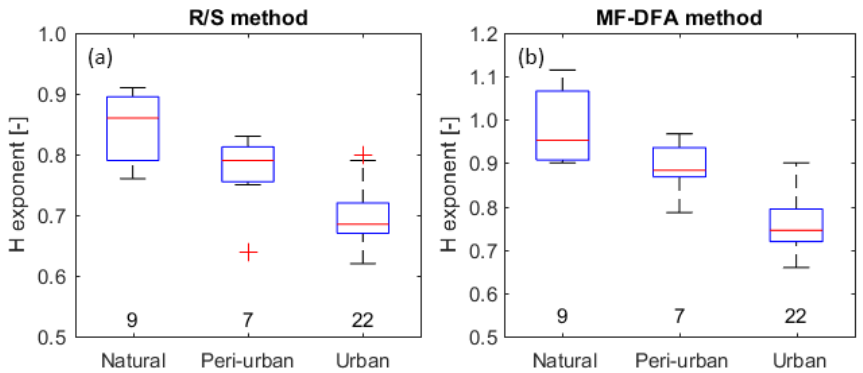
Figure 2. Empirical probability distributions of the H exponent of the streamflow series estimated with the R/S method (a) and with the MF-DFA method (b) grouped into natural ( U< 5%), peri-urban ( U = 5–15%) and urban ( U> 15%) catchments in the USA and Australia. Numbers below the box plots indicate the number of data points used to generate the empirical